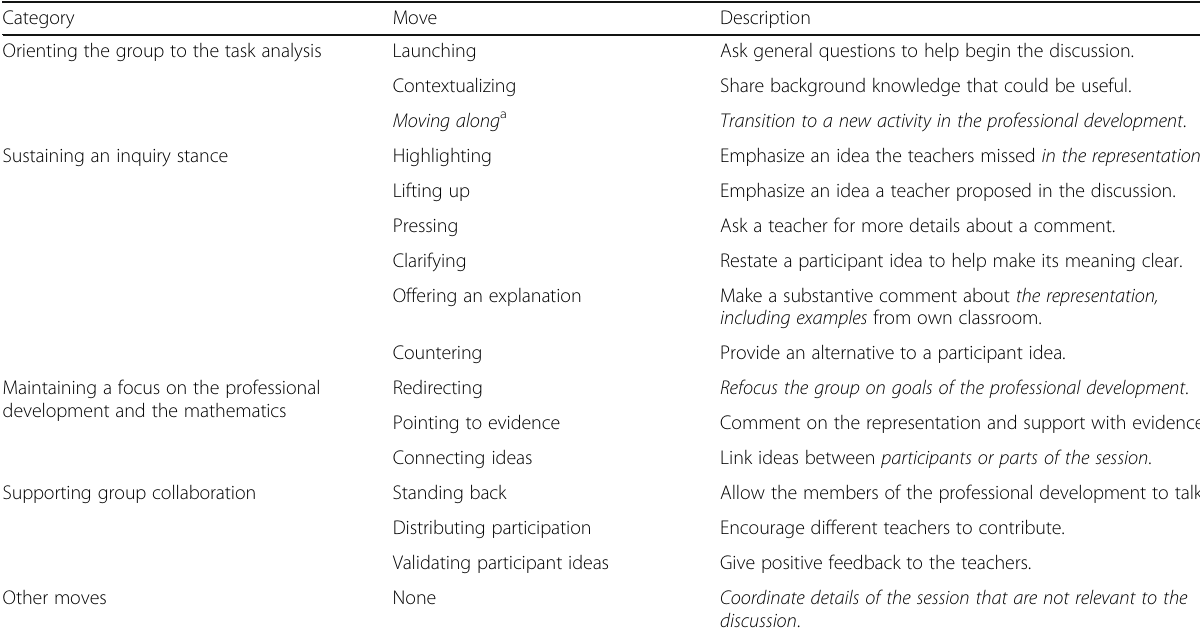
Table 2 Effective facilitation moves for combined PD according to González et al. (2016)